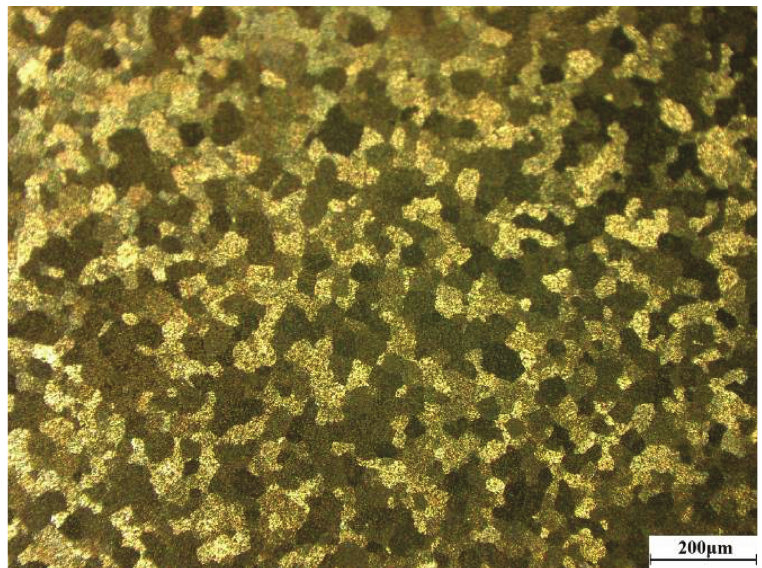
Figure 1: Microstructure of 1060 aluminum after annealing treatment.